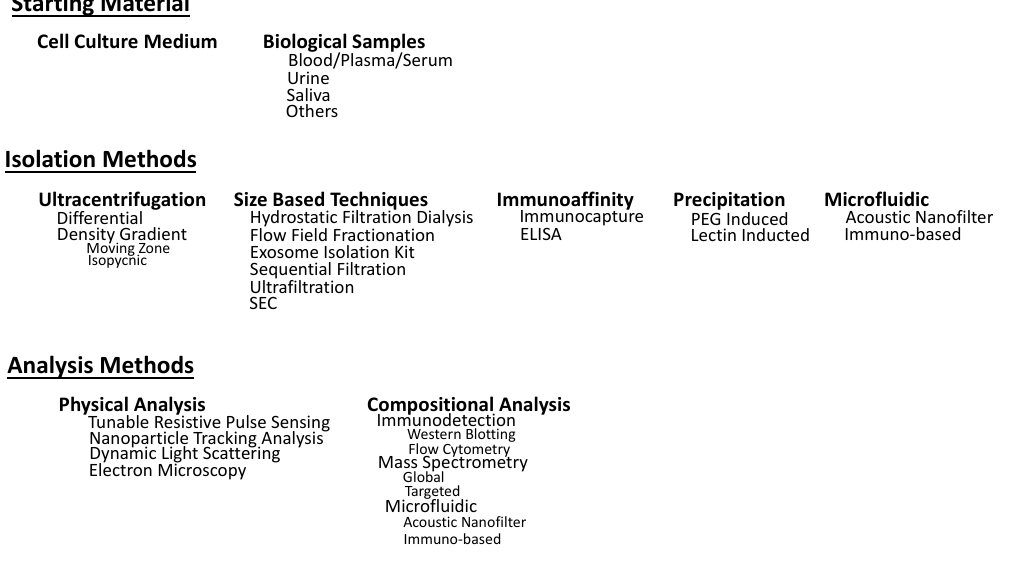
Figure 2. Overview of isolation and analysis covered in this review.